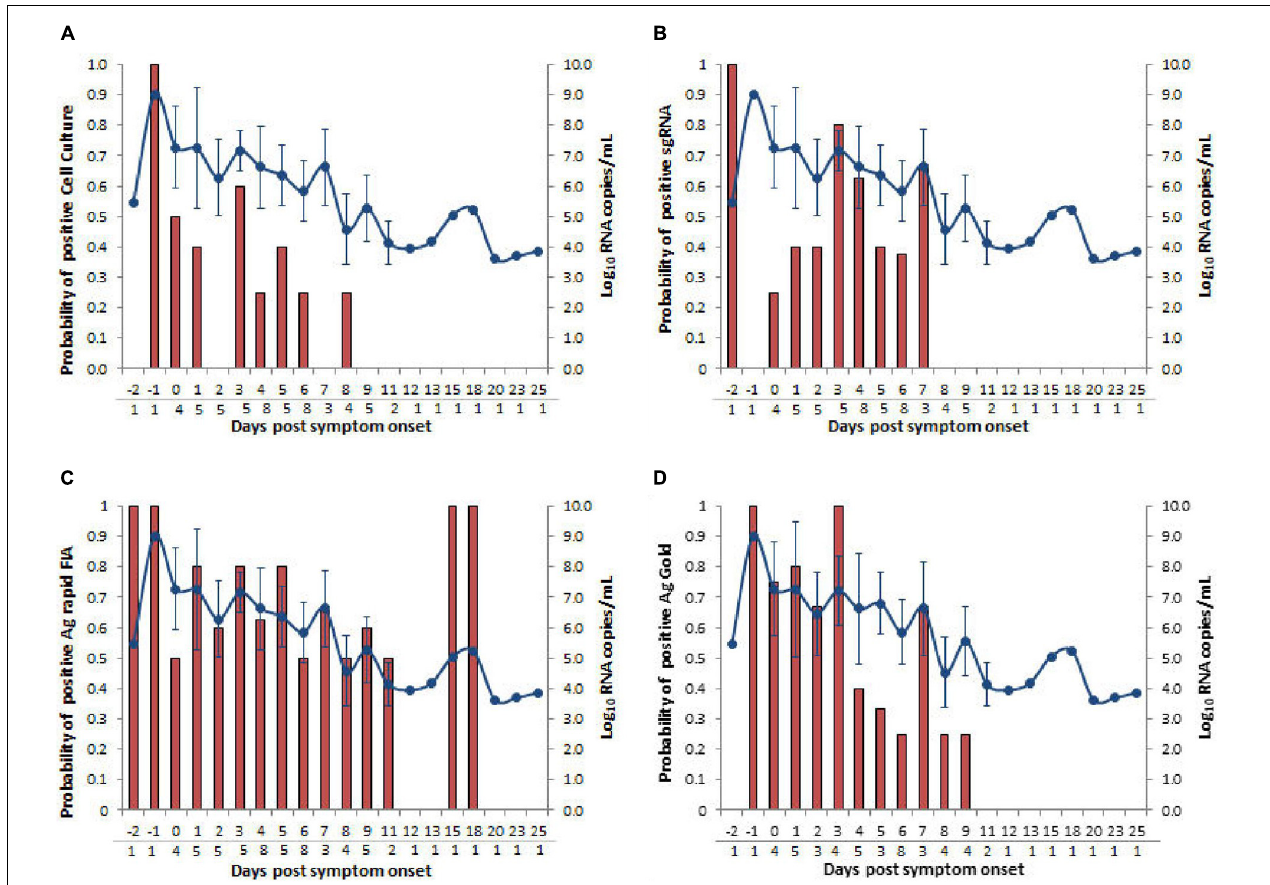
FIGURE 6 | Comparison of days post-symptom onset to the probability of positive and SARS-CoV-2 N gene viral load RNA copies/mL. Four types of assays, (A) cell culture on Vero cells (B) subgenomic RNA (sgRNA), (C) Ag rapid FIA, and (D) Ag Gold were analyzed. Viral loads are represented by the line graph with circles. Probability of positive is depicted by the bar graph. The numbers of samples tested according to days post-symptom onset are presented below the gray line on the x